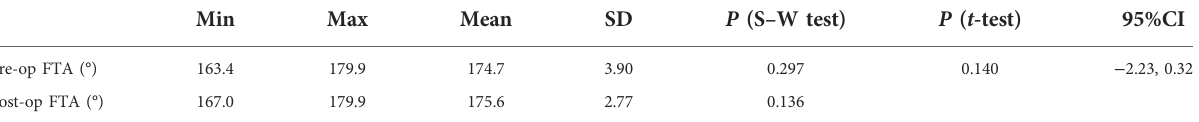
TABLE 2 Pre-operation and post-operation FTA comparison.